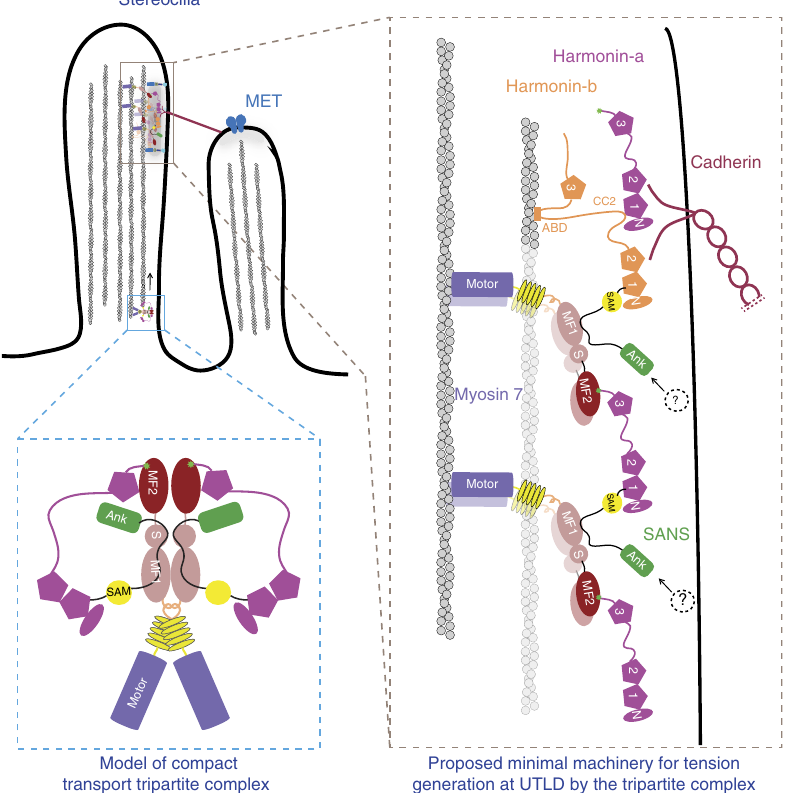
Figure 6 | The proposed Myo7a tip link complex. A cartoon view of stereocilia tip link. The upper tip link density (UTLD) is highlighted in grey. This region clusters several Usher syndrome proteins, as well as molecular motors implicated in adaptation such as Myo1c and Myo7a. A compact transport complex with Myo7a is shown at the base of the stereocilia moving up towards the tip link; and the proposed model shows that this complex consists of harmonin-a, SANS and Myo7a (blue box). Brown box: a proposed, much-simplified model showing a potential mechanism for Myo7a recruitment to the UTLD based on known interactions within the tripartite complex. Harmonin-a can crosslink two motors by interacting directly with a Myo7a via PDZ3c/MF2 interactions (mediated by the Cter motif, green star) and indirectly with another Myo7 via SANS/MF1. The motor in this case can be either monomeric or dimeric (shown in lighter colours; potentially promoted by SANS dimerization, see Fig. 3e). This network would be compatible with association between different harmonin isoforms. Harmonin-b (in orange) would provide the means to tether this network to actin filaments via its ABD while its CC2 region could extend the network by recruiting another harmonin. Thus, different numbers of Myo7a motors and harmonin-b could potentially be crosslinked and regulate the stiffness and extent of movement of this Usher protein assembly network, which would also bind the cadherin tails via harmonin. Also indicated is the potential interaction of the SANS ANK domain with other unknown partners (dotted circle). MET: mechano-electrical transduction